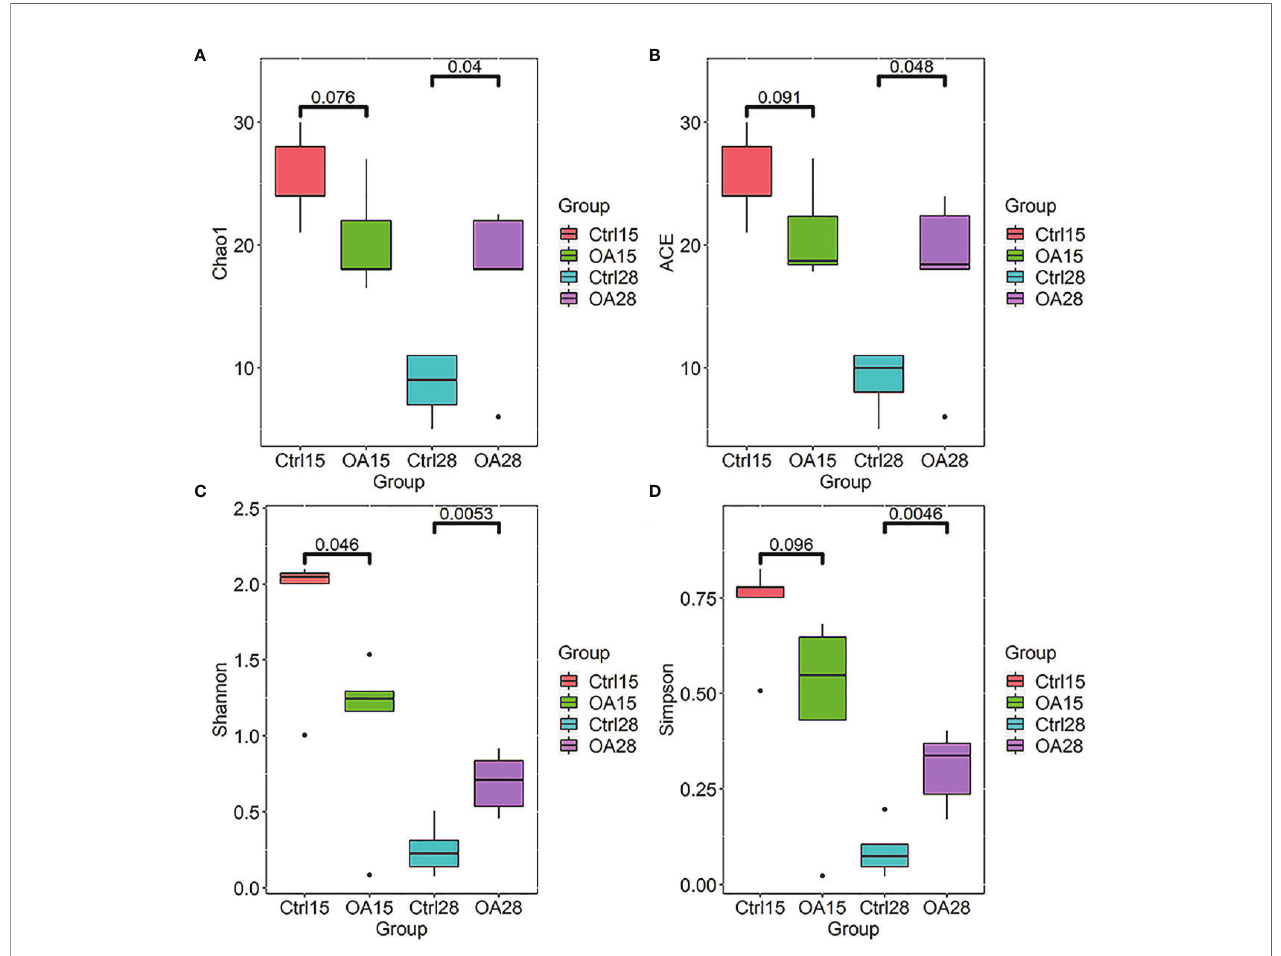
FIGURE 3 | The a -diversity index of the intestinal fl ora in piglets. The Chao1 diversity (A) , ACE diversity (B) , Shannon diversity (C) , and Simpson diversity (D) based on OTU relative abundances were shown by R software (version 3.6.1) with the ggplot2 package. The boxplots represent the diversity measures for the 5 analysis groups (center line, median; box limits, fi rst and third quartiles; whiskers, 1.5 × interquartile range). All outliers are plotted as individual points. The number up to the two groups means p value which is calculated by the Student ’ s